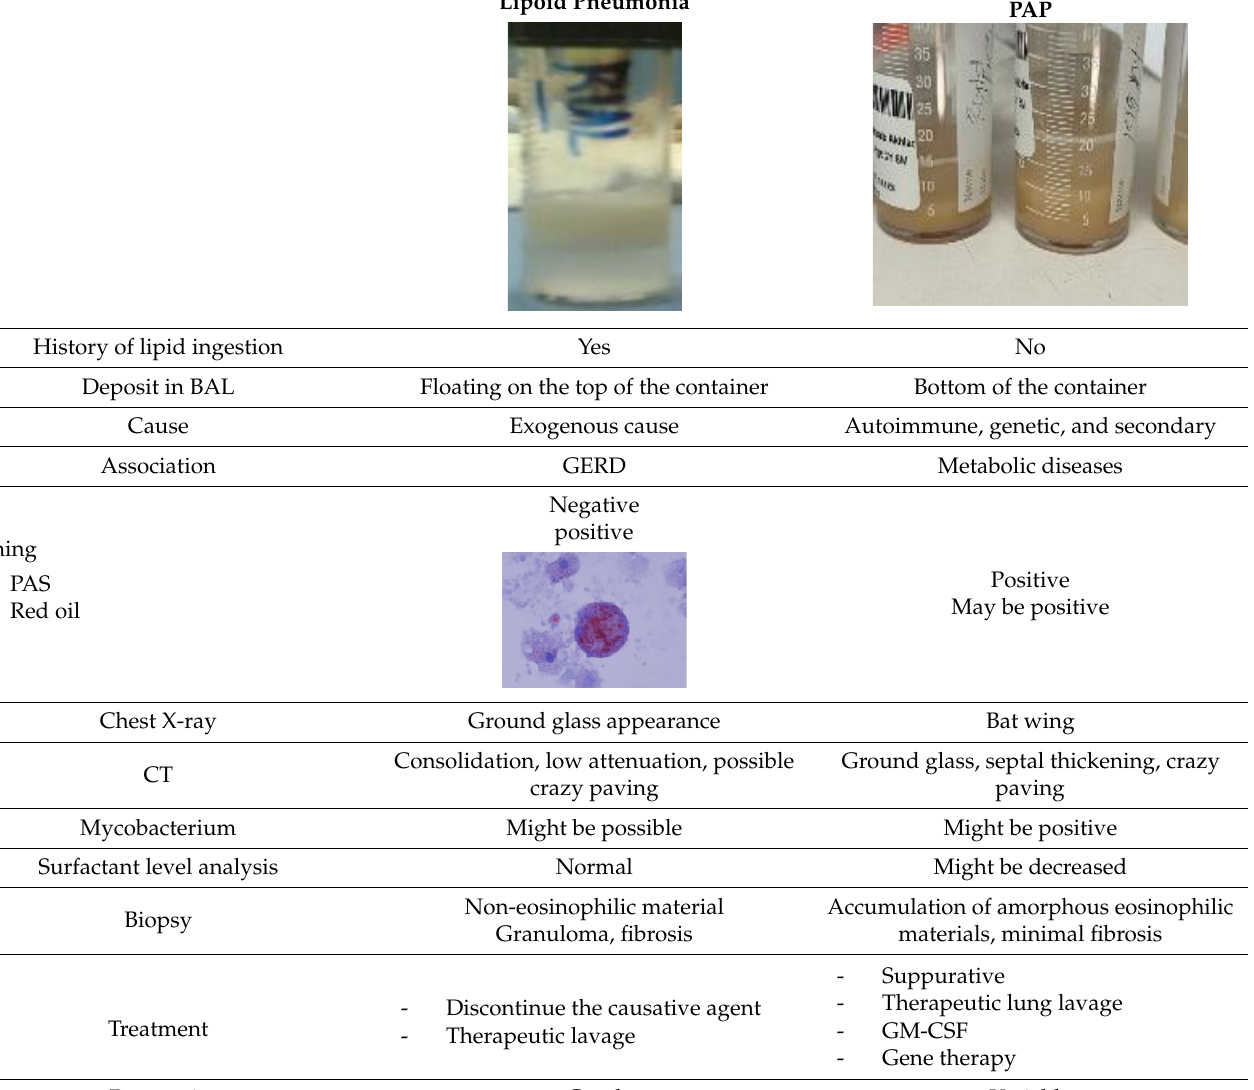
Table 1. Characteristics of Lipoid pneumonia versus pulmonary alveolar proteinosis.